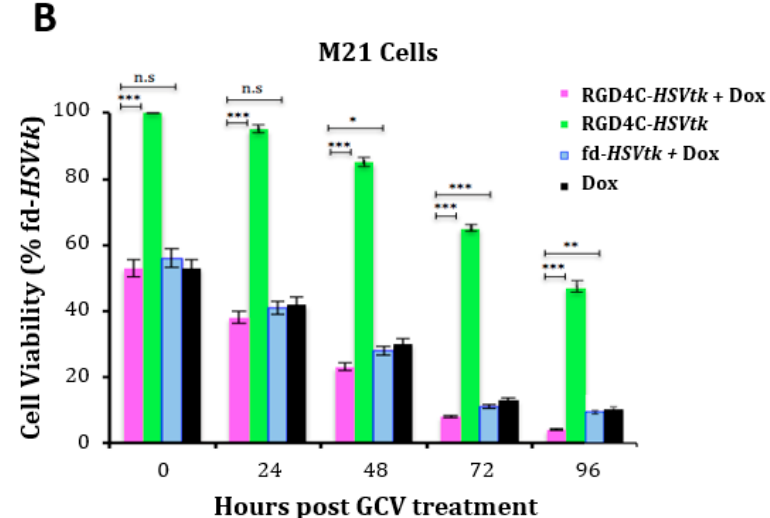
Figure 2. Dox amplifies the suicide gene killing of cancer cells by targeted RGD4C / AAVP- HSVtk . 9L ( A ) and M21 ( B ) cancer cells grown in 48-well plates, 60–80% confluent, were transduced with the targeted RGD4C / AAVP- HSVtk (RGD4C- HSVtk ) vector carrying the HSVtk gene or control nontargeted AAVP- HSVtk (fd- HSVtk ) in the presence or absence of Dox, 0.5 µ M for 9L and 0.6 µ M for M21 cells. The cells were treated with GCV (20 µ M) at day 3 post-vector transduction and renewed daily. Cancer cell killing was quantified at 0, 24, 48, 72 and 96 h post-GCV treatment by using the trypan blue exclusion methodology. Results were normalized to the nontargeted fd- HSVtk vector. The experiments were repeated twice in triplicates, and the results shown are representative of one experiment. * p < 0.05, ** p < 0.01, *** p < 0.00 and n.s: nonsignificant